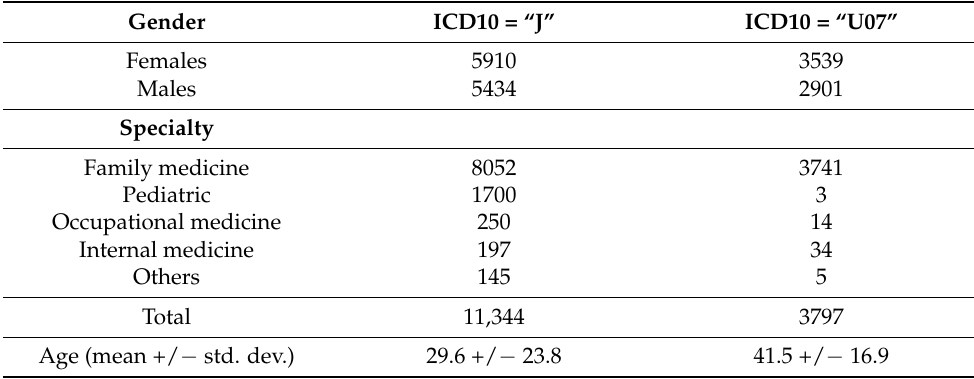
Table 2. Description of respiratory